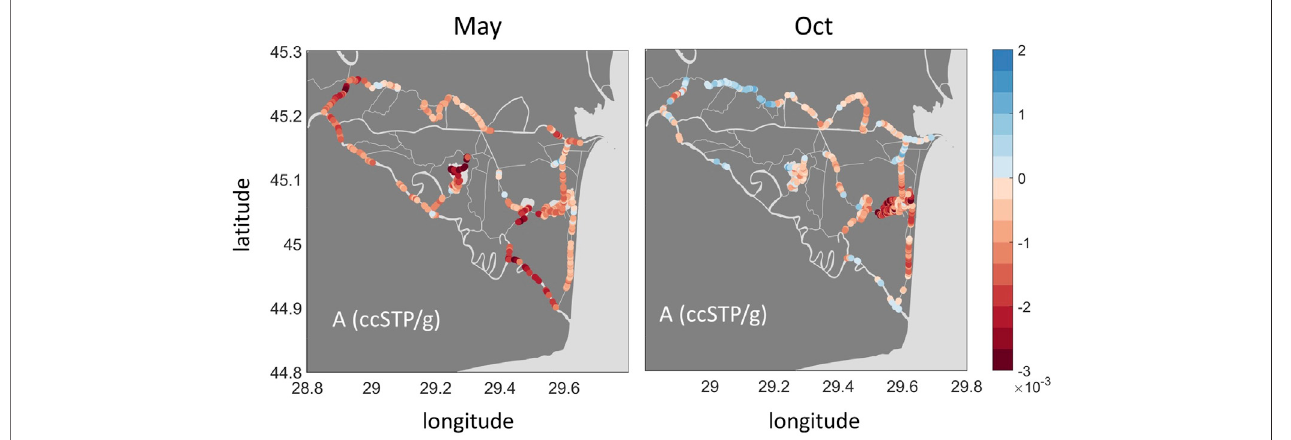
FIGURE 9 | Spatial variability in the estimates of excess air A for May (left) and October